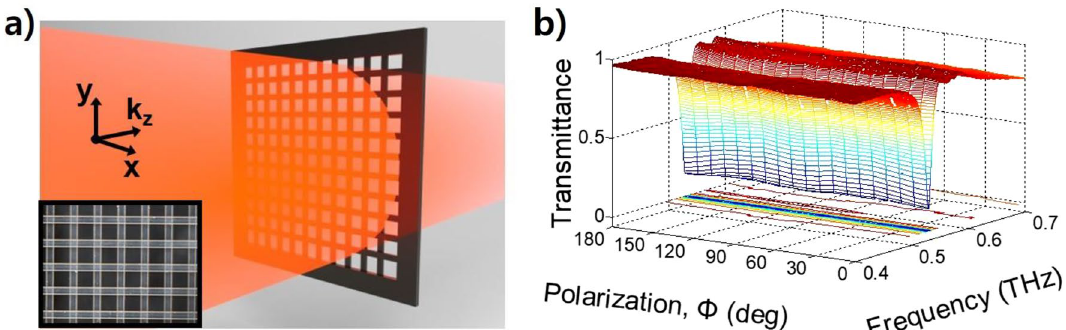
Figure 7. Characterization of the transmittance of a bilayer GMR filter. ( a ) Schematic diagram of the bilayer GMR filter with two-monolayer films attached at an angle of 90°. The inset photo shows the bilayer GMR filter whose gratings form cross strips. ( b ) Measured transmittance according to the polarization angle and THz